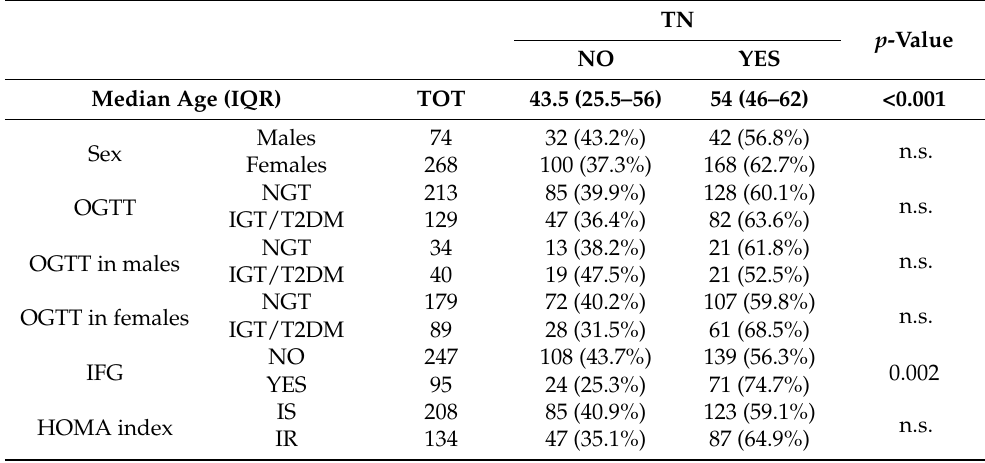
Table 2. TN distribution according to sex, OGTT categories, FPG categories and HOMA index. Percentages refer to the nominal group in the corresponding line.